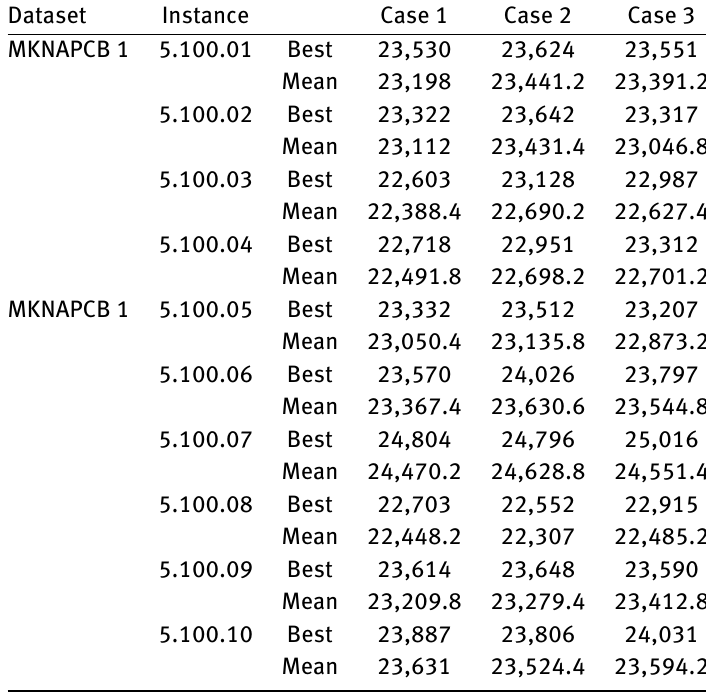
Table 6: Experimental results on effect of Crossover Rate on MKNAPCP 4